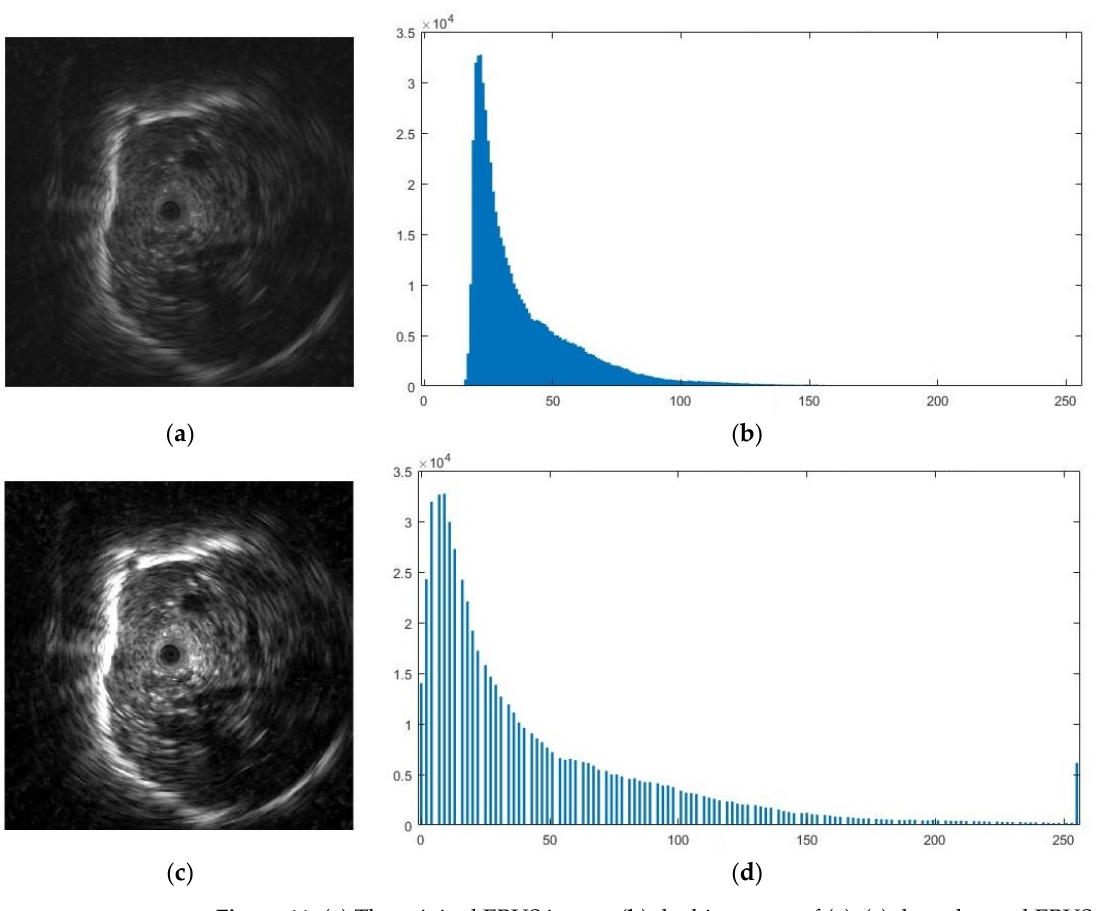
Figure 11. ( a ) The original EBUS image; ( b ) the histogram of ( a ); ( c ) the enhanced EBUS image; ( d ) the histogram of ( c